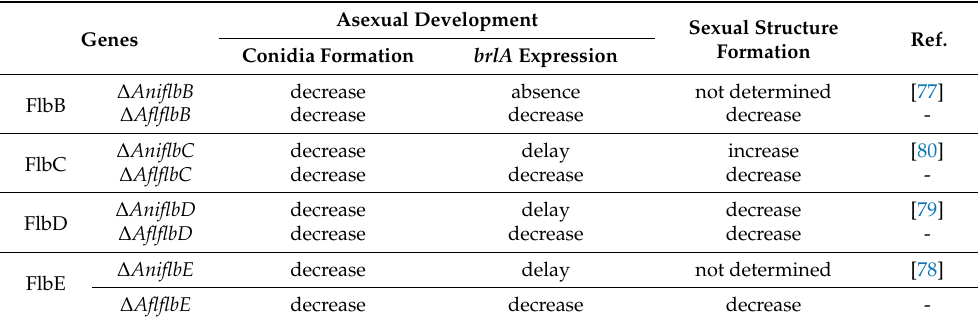
Table 2. Comparison of the developmental phenotypes of the ∆ flb mutant strains in A. nidulans and A. flavus